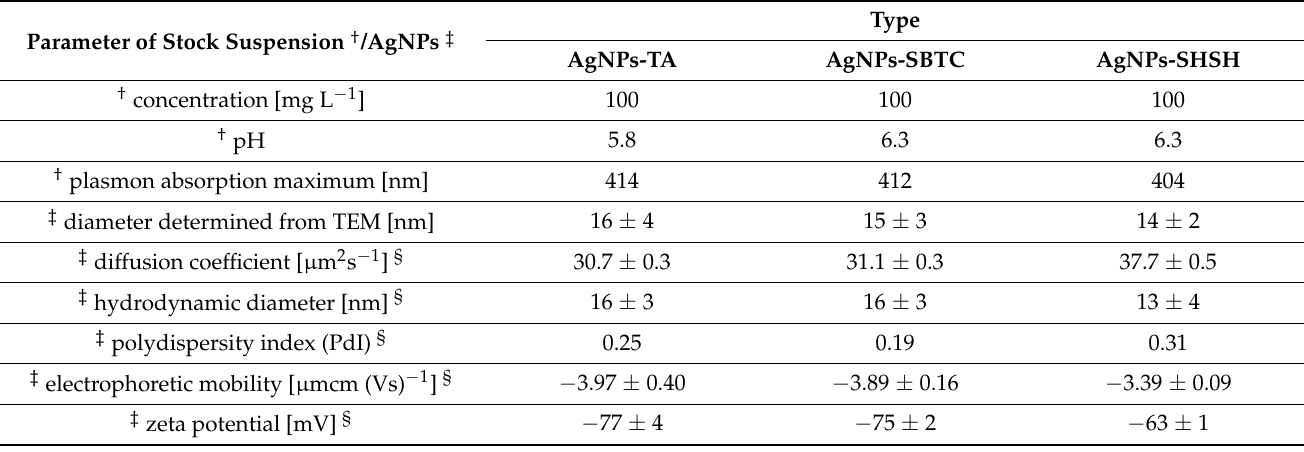
Table 1. Selected physicochemical properties of the AgNPs and their aqueous